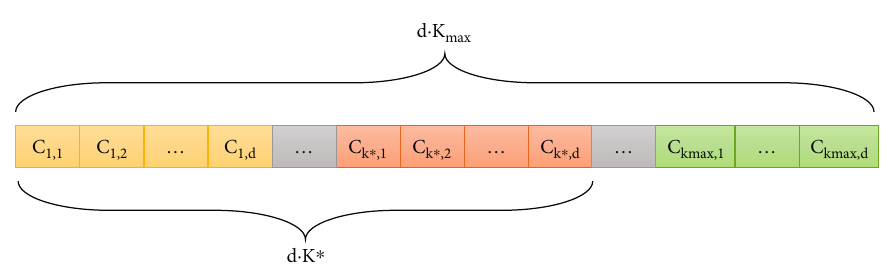
Figure 2: Schematic diagram of chromosome